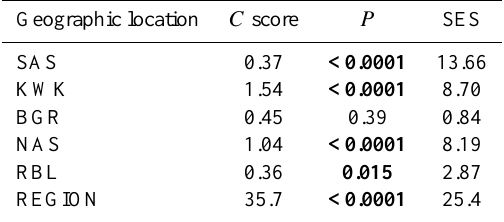
Table 3. Results of co-occurrence analyses for the dominant OTUs (20 reads, 3 sites). Significant results are presented in bold. SES refers to standardized effect